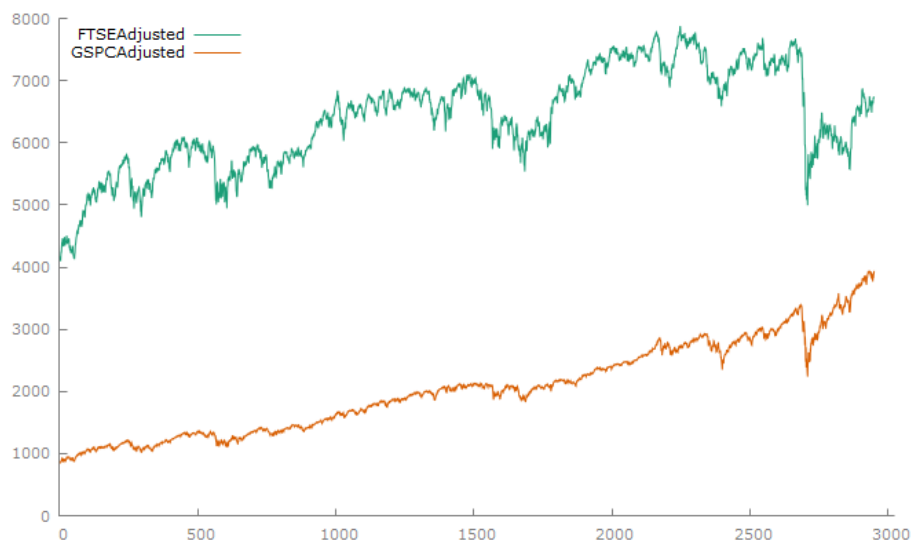
Figure 2. Plots of daily values of the S&P500 and FTSE